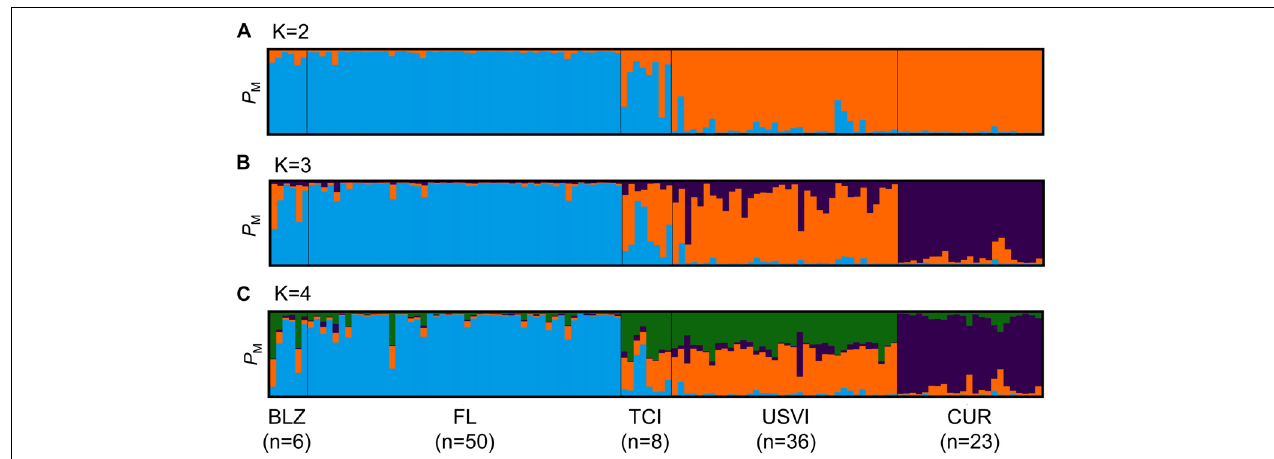
FIGURE 6 | Population structure results for Dendrogyra cylindrus . Each vertical bar represents a unique multilocus genotype. Probability of membership to a cluster is plotted on the y -axis. (A ) S TRUCTURE results for D. cylindrus revealed two separate clusters ( K = 2, indicated by color). (B) S TRUCTURE results for D. cylindrus when K = 3. (C) S TRUCTURE results for D. cylindrus when K = 4. Individuals are grouped by sample location; abbreviations are the same as in Figure 1 .